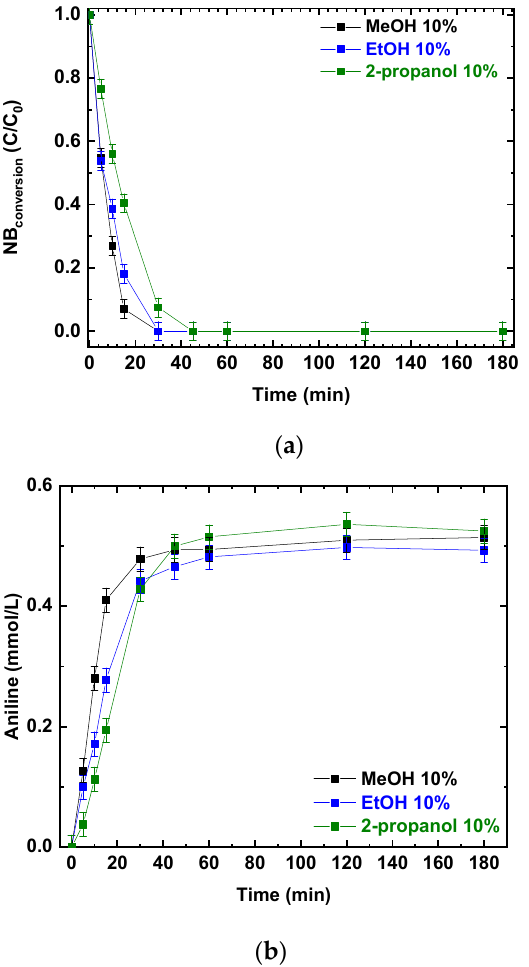
Figure 2. Comparison of the photocatalytic reduction of NB to AN using P25, with different reducing agents (MeOH, EtOH, 2-propanol): ( a ) NB conversion as a function of irradiation time; ( b ) AN production as a function of irradiation time. Reaction conditions: NB 1 mmol/L; water 100 mL; 0.5 g/L TiO 2 (P25); temperature 25 °C; reaction time 180 min. Error bar ±0.02%.